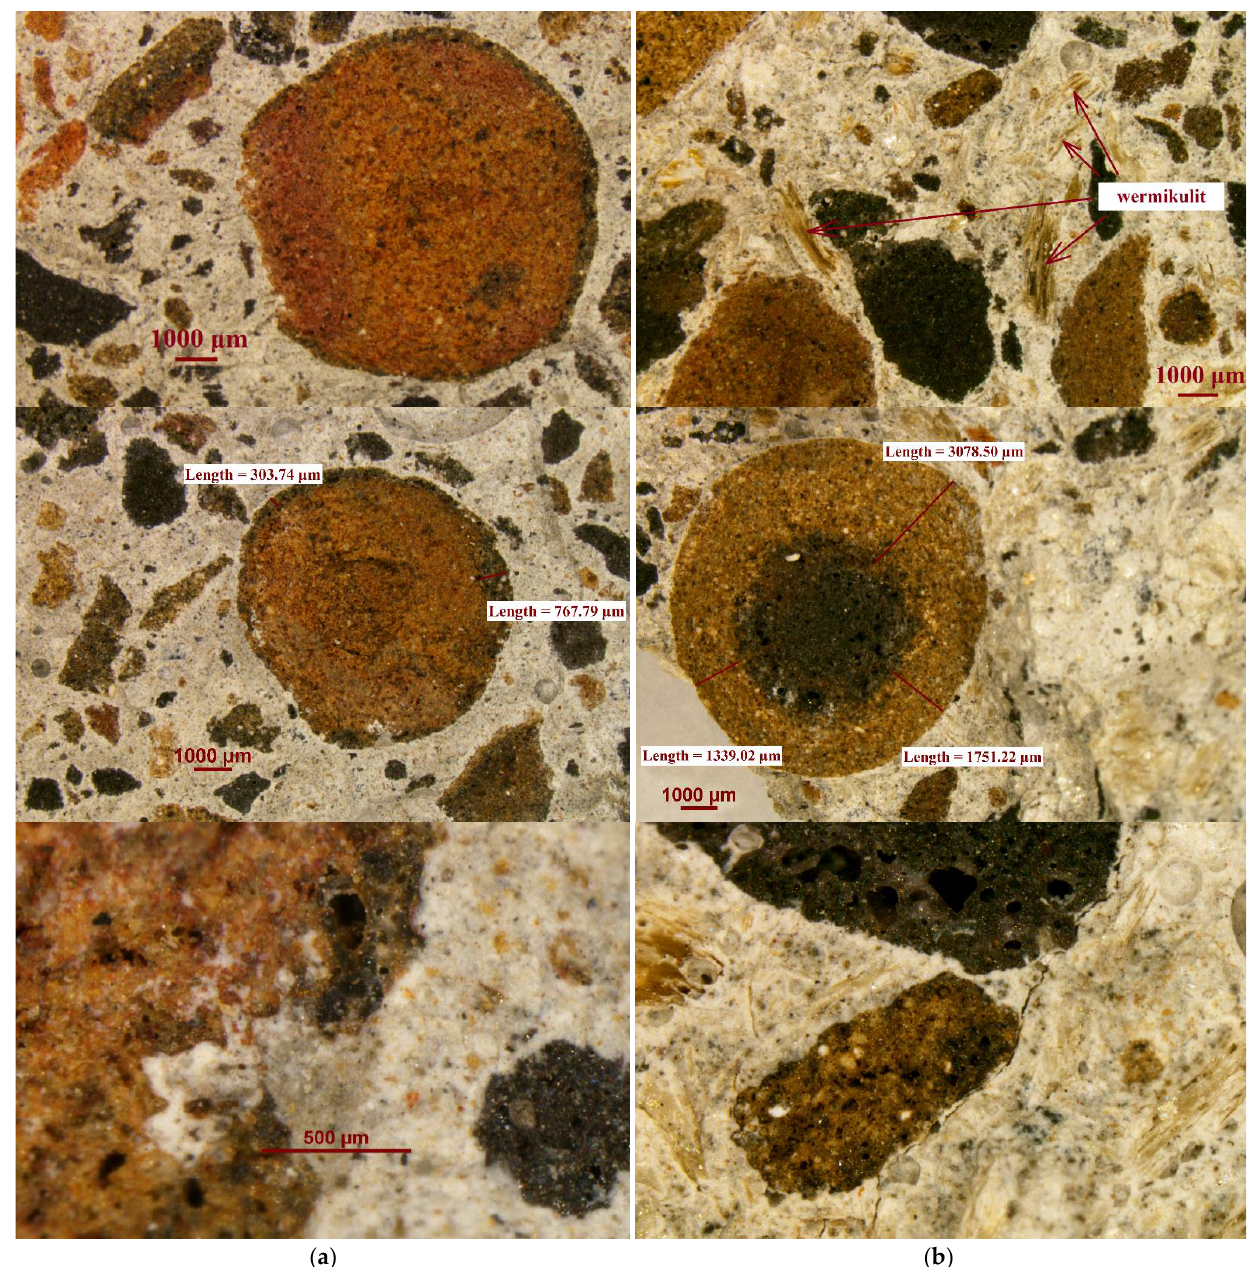
Figure 13. Microscopic photos of ( a ) SFA concrete and ( b ) SFA + EV concrete.